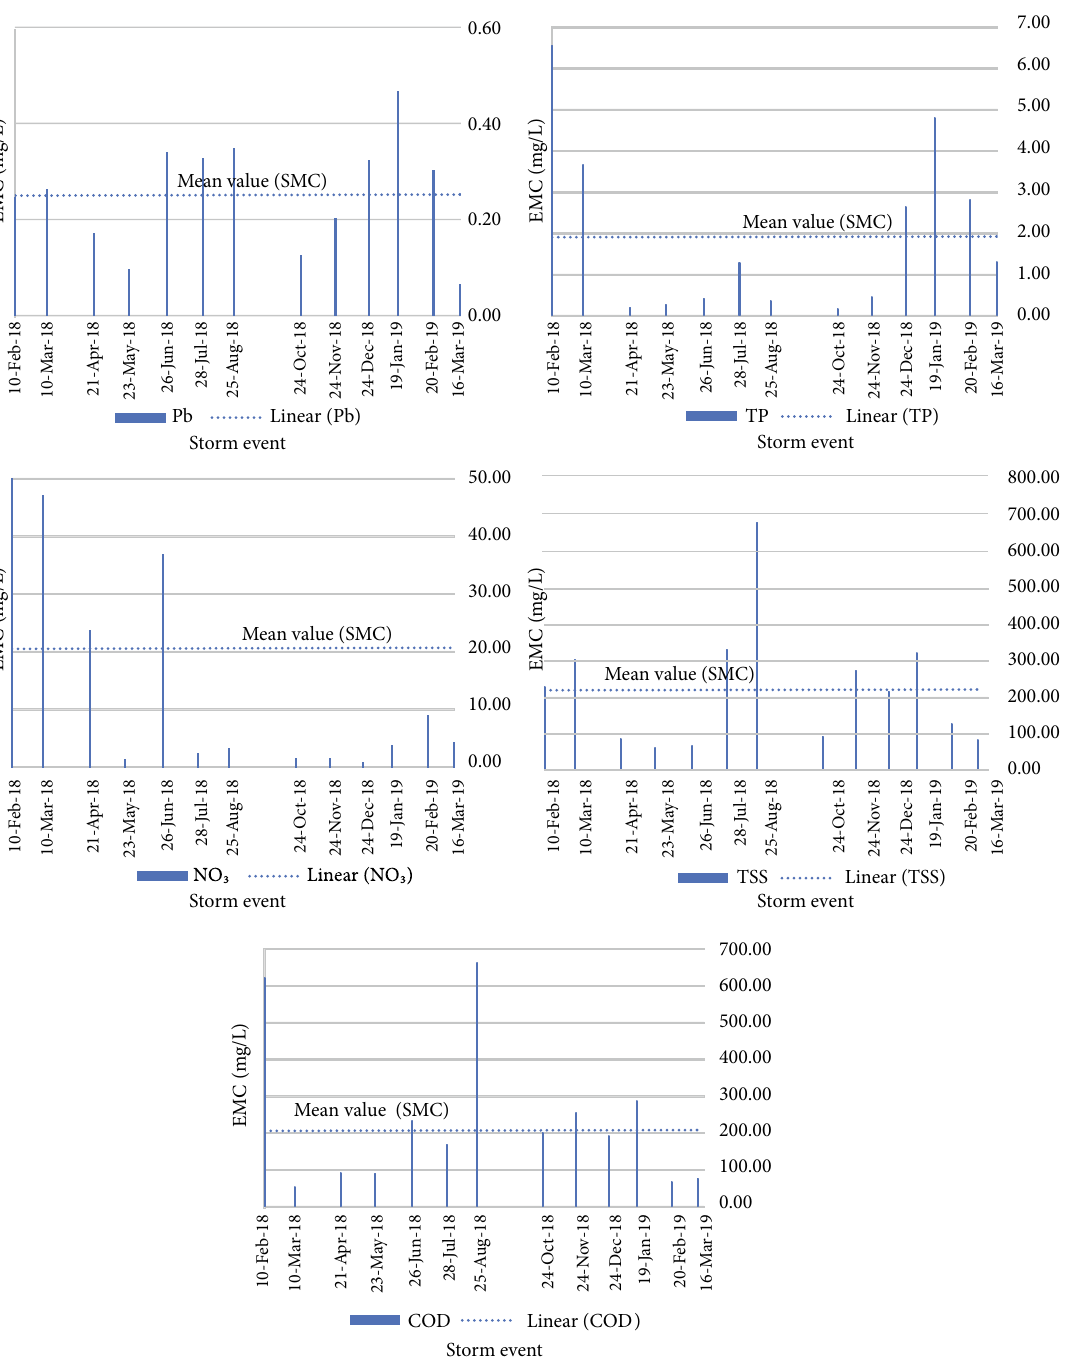
Figure 5. EMC (mg/L) of pollutants for each